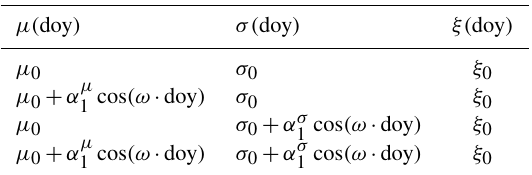
Table 1. All possible models in the first step of the stepwise regres- sion (GEV case) with ω = 2 π 365 . 25